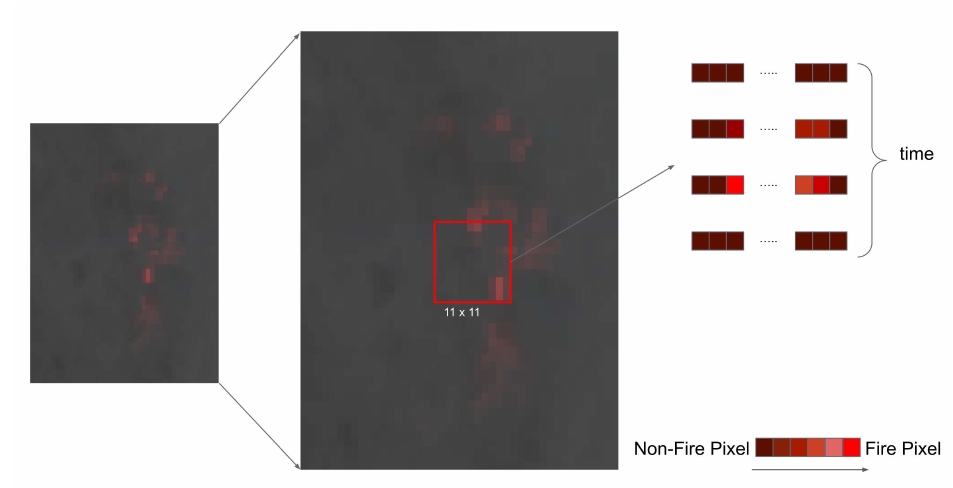
Figure 6. Preprocessing of the GOES-R imagery to generate time-series embeddings. As shown in the Figure 7, the time-series of the embeddings show the progression of the wildfire. For each row, it represents the flattened 11 by 11 image patch. The neighboring pixels above the center pixel locates in the columns of the left, while the neighboring pixels below the center pixel are in the right columns. And the center pixels are located at column 60. For each column, it represents the fluctuation of band values. When the wildfire progresses from bottom-right to top-left in given image patch, the highest value in its neighborhood flows from right to left in the embedding. For each 11 pixels in the embedding map, it can be observed that bright spots shifted from right to left. Also, the pixels on the right columns tend to have more numbers of high value pixels than the pixels on the left columns. This represents the wildfire is at the bottom of the image patch. Especially, when the highest value locates at the center pixel, the center pixel is more likely to be classified as the fire pixel. The time-series model is possible to leverage the fluctuation of values of center pixel and its neighboring pixels at all previous timestamps to classify the center pixel.